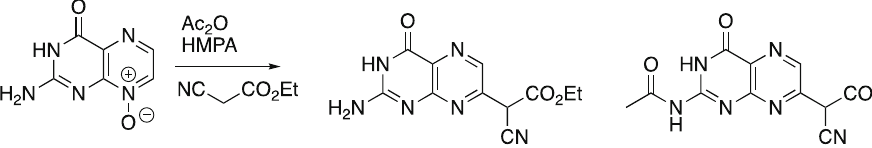
Figure 2: Reactivity of pterin N - oxides reported by Taylor and